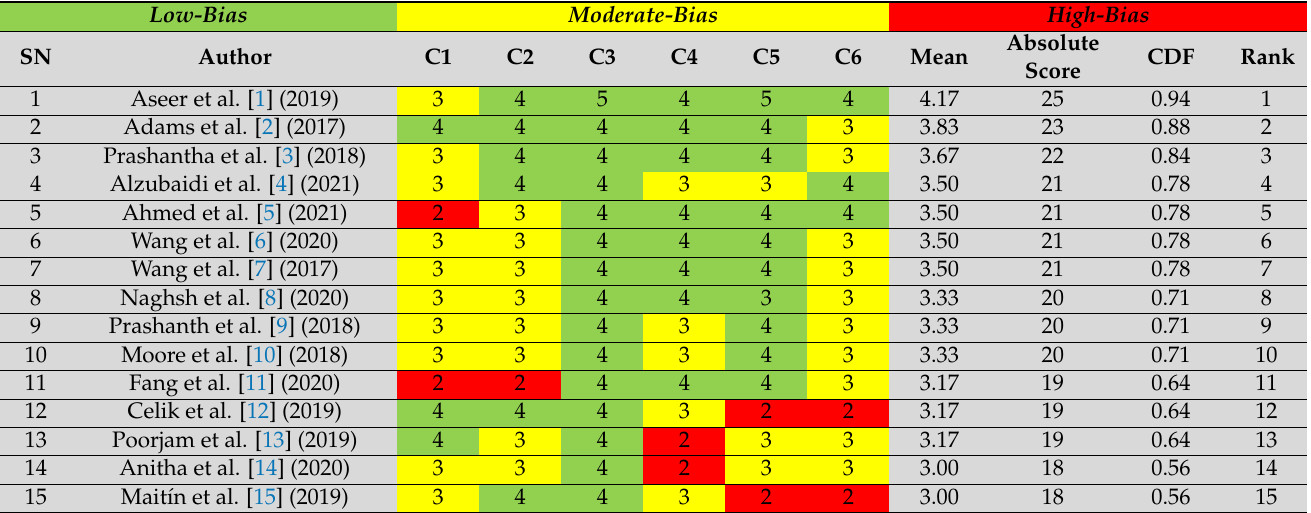
Table 2. Ranking of the selected